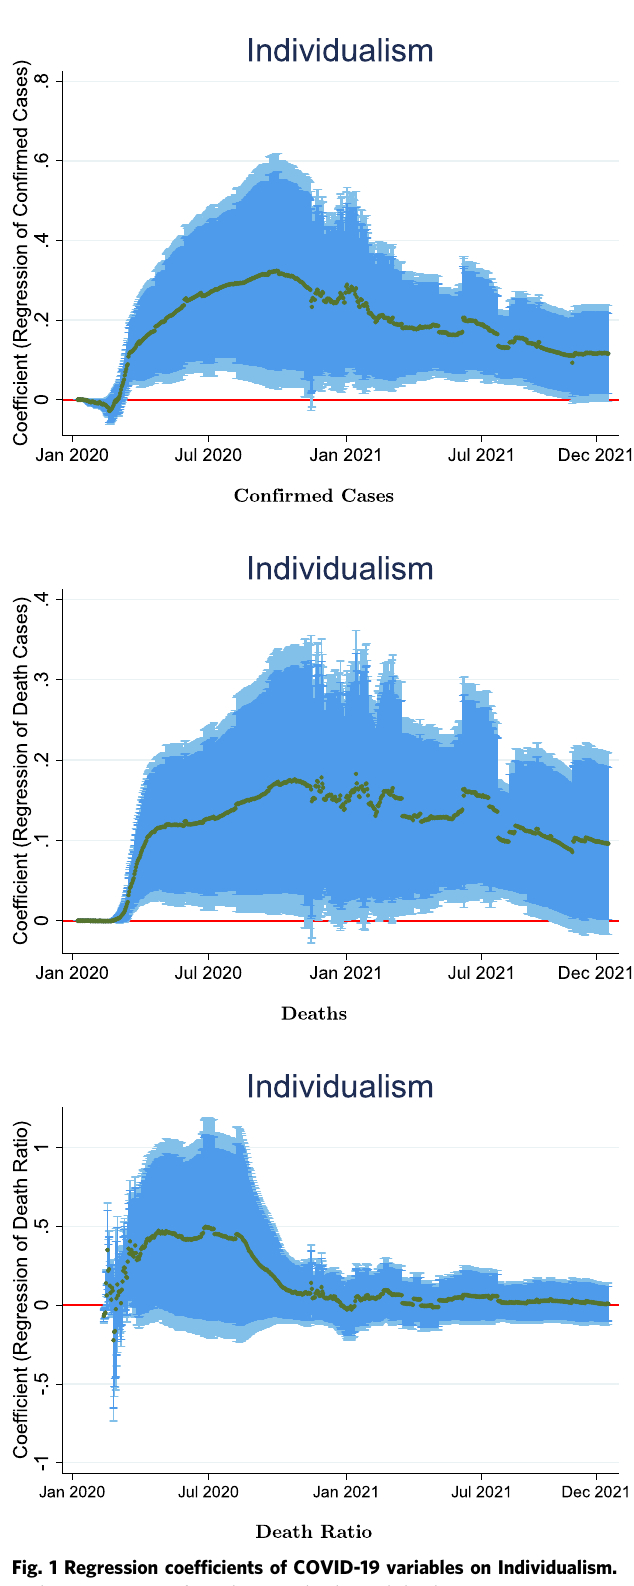
Fig. 1 Regression coef fi cients of COVID-19 variables on Individualism. Daily COVID-19 con fi rmed cases, deaths and death ratio regression coef fi cients (95 and 90% con fi dence interval) on Individualism , controlling for vaccination, virus testing, relative days, country characteristics and continent fi xed effects, using the number of Nobel Prize winners as an instrument, 2020 and